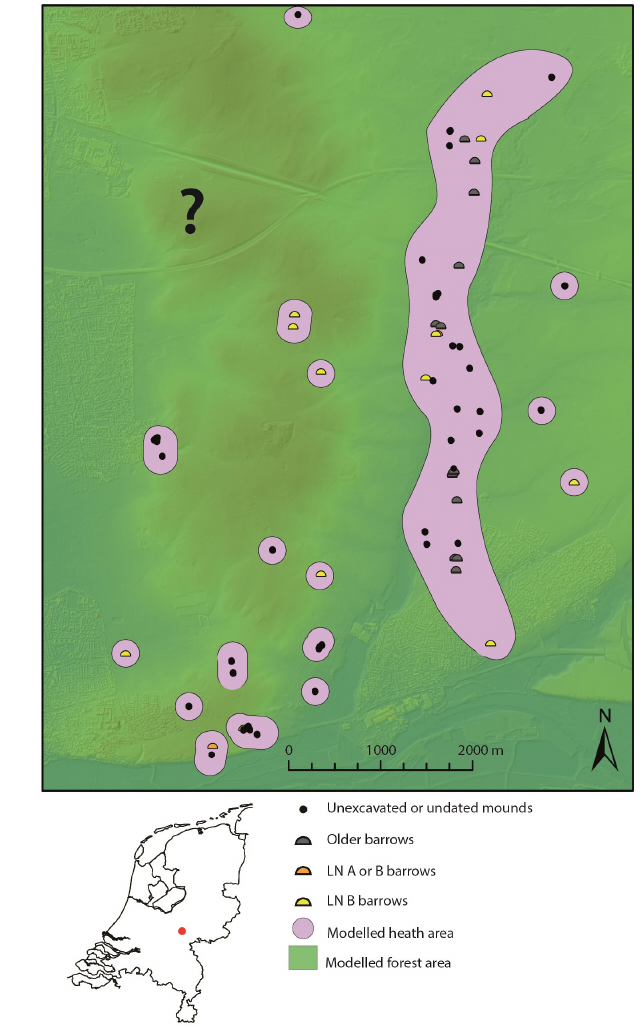
Figure 5. Barrow alignments of Renkum, situated in a (hypotheti- cal) long-stretched heath area surrounded by forest. The vegetation reconstruction is based on palynological data from barrows. An ex- act reconstruction of the forest area is therefore not possible (indi- cated by the question mark), since barrows are not present in those areas. The figure is based on the digital elevation model of the AHN ( © www.ahn.nl). Figure after Doorenbosch (2013, Fig.